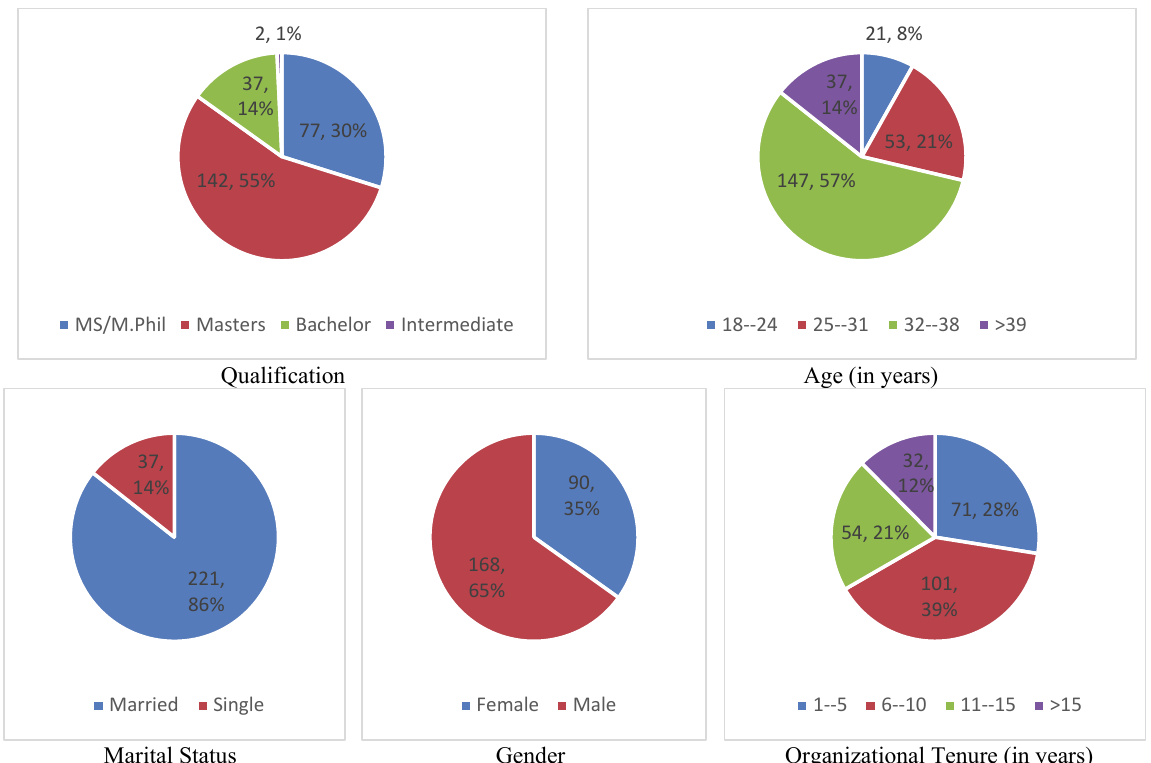
Fig. 2. Personal Characteristics of the